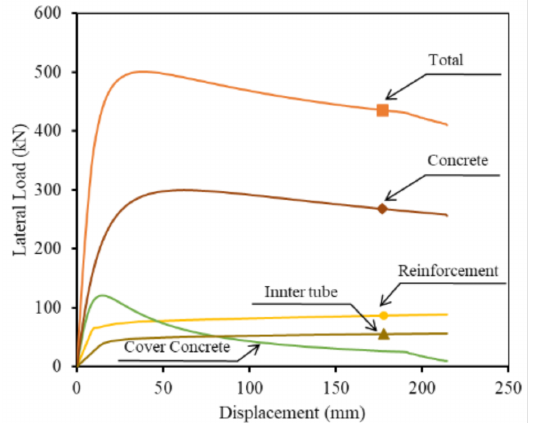
Figure 25. Lateral load-displacement of each member (S-C